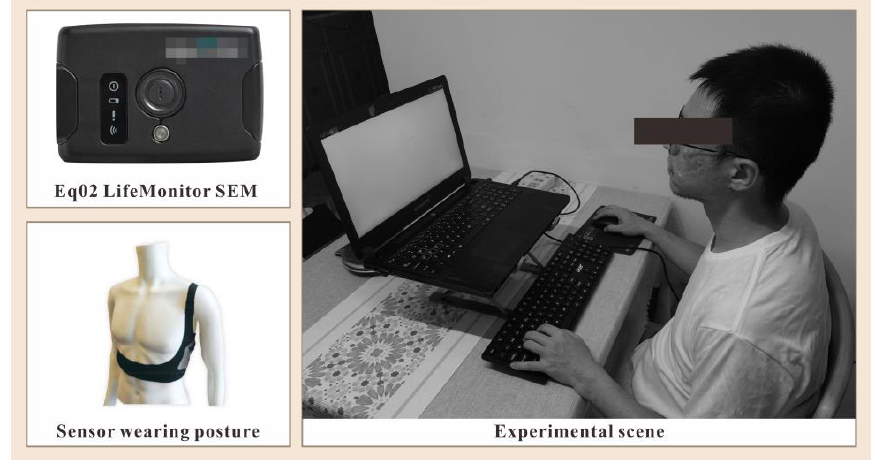
Figure 5. Experimental scene.